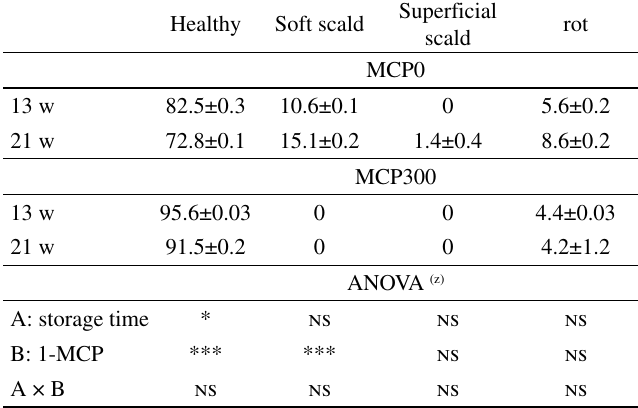
Table 5 - Storage disorders in control (MCP0) and 1-MCP